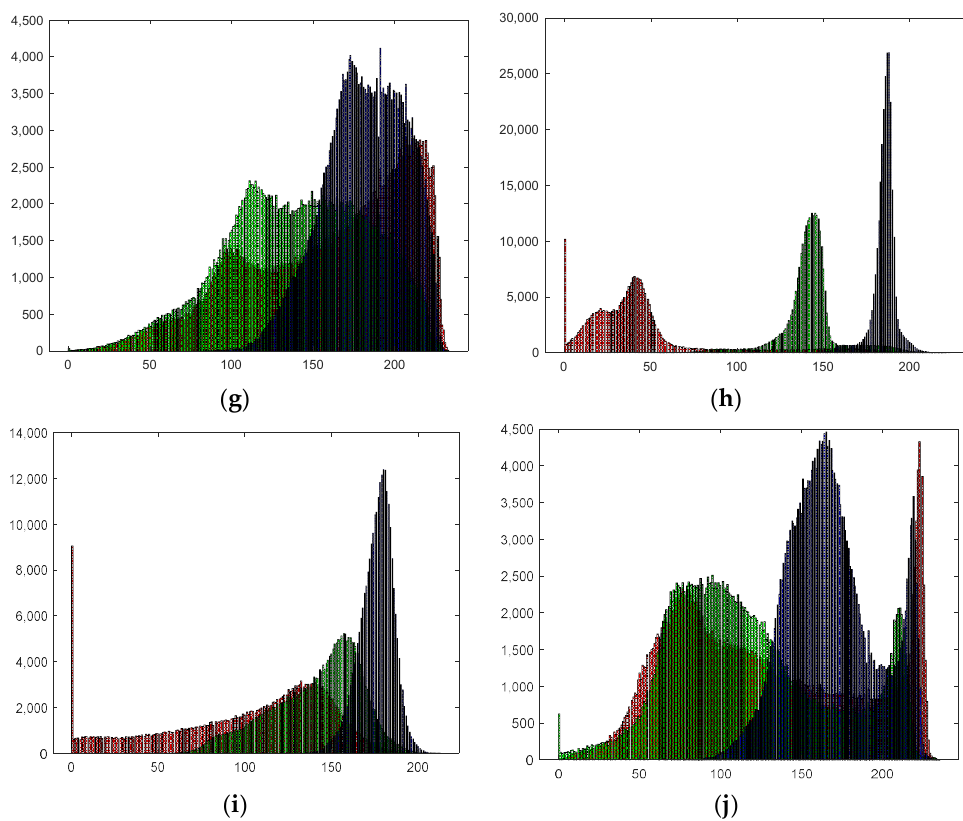
Figure 16. The histograms of plain images: ( a ) histogram of Peppers; ( b ) histogram of Baboon; ( c ) histogram of Airplane; ( d ) histogram of House; ( e ) histogram of Penguin; ( f ) histogram of Sky; ( g ) histogram of Railway; ( h ) histogram of Sea; ( i ) histogram of Water; ( j ) histogram of Building (The red, green and blue part represent the pixel distribution of R, G and B channels respectively).